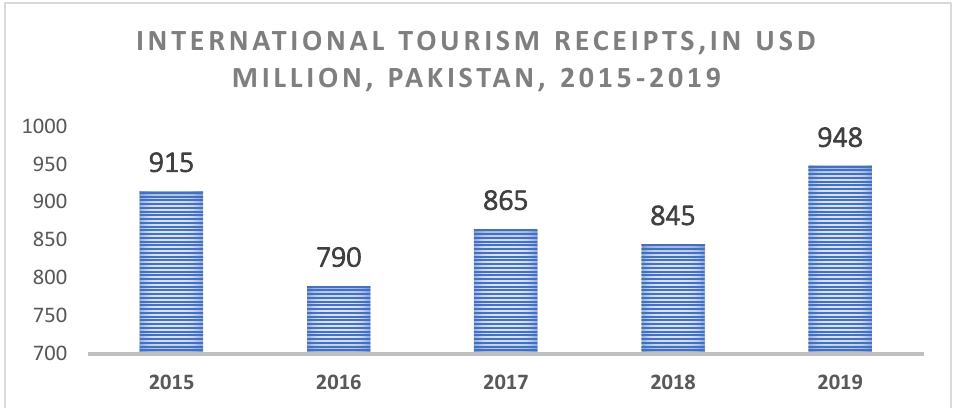
Figure 1. Local food is defined as “ products which not only symbolize tourism destinations but also vividly demonstrate local traditional culture” [31]. Source: Mordor Intelligence. Reprinted/adapted with permission from https://www.mordorintelligence.com/industry-reports/market-entry-tourism-and-hotel-industry-in-pakistan, accessed on 9 May